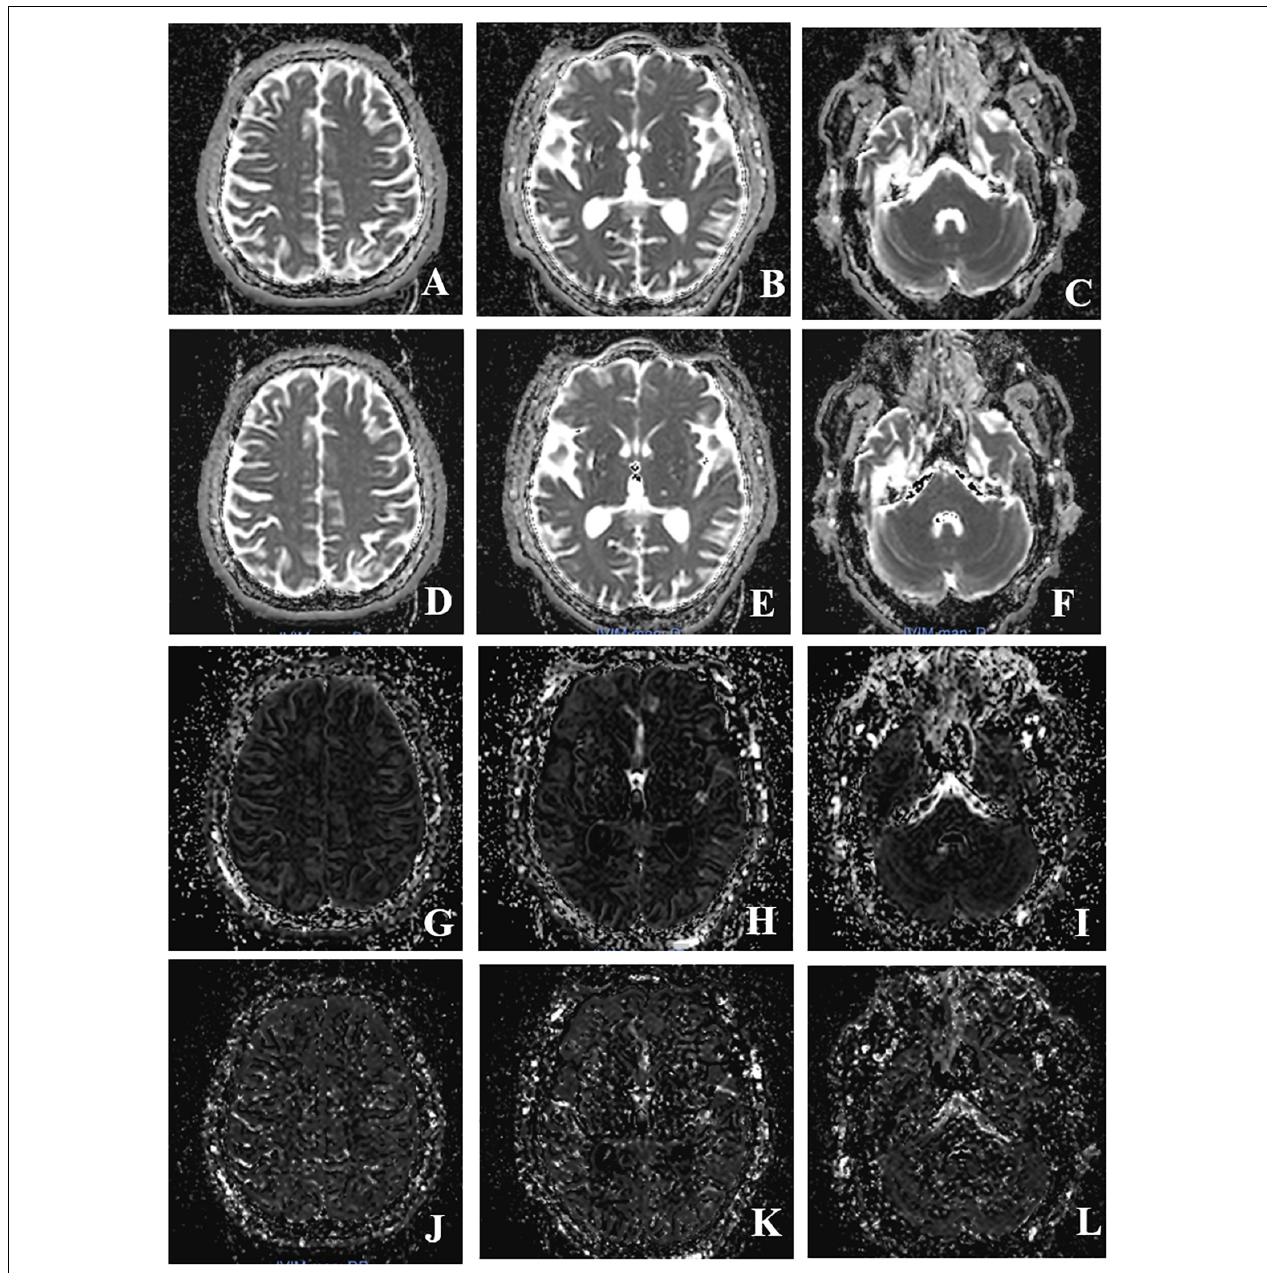
FIGURE 1 | Intravoxel incoherent motion MRI imaging obtained after post-processing (the columns show three different levels, peripheral white matter level, basal ganglia level, cerebellar hemisphere level; the line shows four different IVIM parameters, ADC, D, f, D ∗ value). (A–C) Image of ADC value; (D–F) image of D -value; (G–I) image of f value; (J–L) image of D ∗ value.